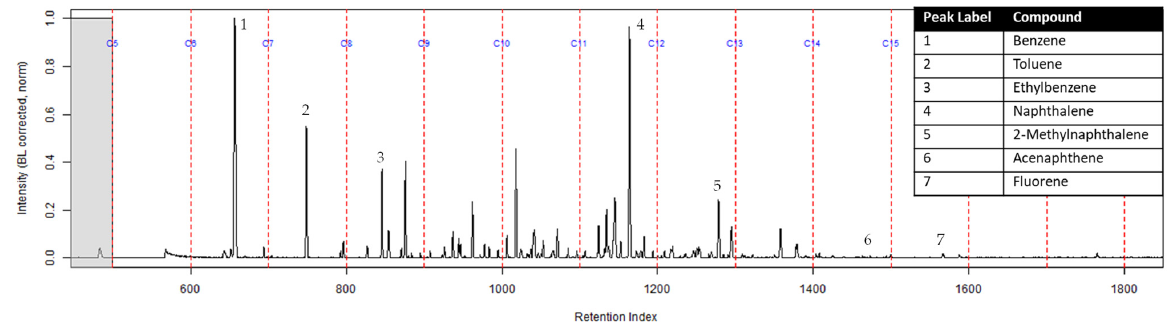
Figure 7. Zoomed TIC of the extract from the ACL within the dosimeter from the can containing 2-min MDDM burned vinyl siding and a railroad tie (maximum peak abundance 4.8 × 10 6 ).